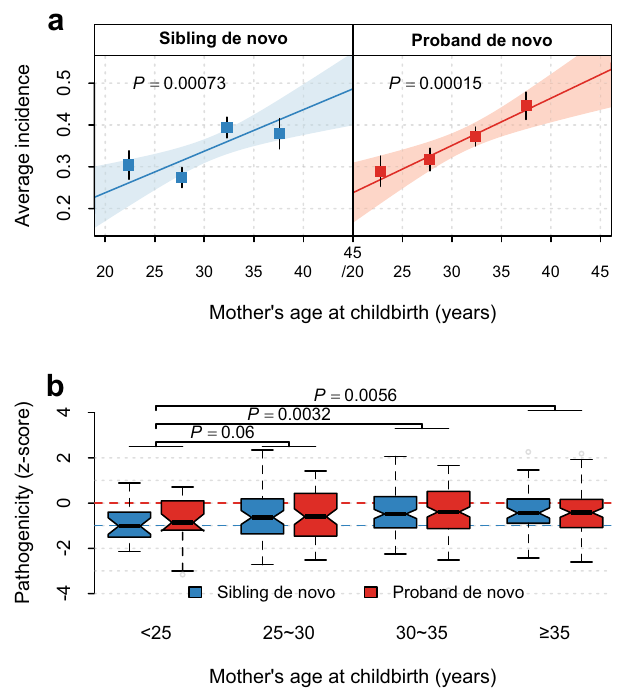
Fig. 3 In fl uence of maternal age at childbirth on de novo heteroplasmies in the SSC. a Maternal age-dependent increase in the number of de novo heteroplasmies in siblings and probands. Points and error bars in each subpanel represent mean ± SEM among the four maternal-age groups (from left to right, n = 217, 514, 665, and 327 siblings, and n = 197, 542, 725, and 471 probands). 215 siblings and 3 probands with missing maternal age information were excluded from the analyses in ( a ) and ( b ). The P value (two-sided) and the shaded area indicate the signi fi cance of the slope and the 95% con fi dence interval of the linear regression line (the solid line), respectively. No signi fi cant difference in slope was found between cases and controls, as shown in Supplementary Table 12. b Box plots for the distribution of pathogenicity z-scores of de novo heteroplasmies at nonsynonymous sites in oxidative phosphorylation genes or at all sites in tRNA genes strati fi ed by maternal age groups at birth (from left to right, n = 23, 63, 113, and 53 in siblings, and n = 29, 73, 133, and 93 in probands). Two-sided P values are from linear regression. Box plots show the median as the center line, 95% con fi dence interval of the median as the notch, the fi rst (Q1) and third (Q3) quartiles as the boundaries of the box, the values of the largest and smallest data points within the range between Q1 – 1.5× interquartile range (IQR) and Q3 + 1.5× IQR as the boundaries of the whiskers, and the outliers beyond this range as the gray